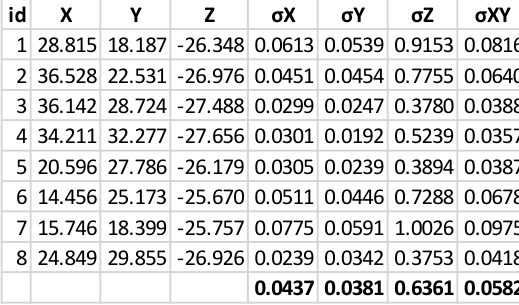
Table 1. Averaged results from ten repetitions of trilateration with different random gaussian noise. All results in